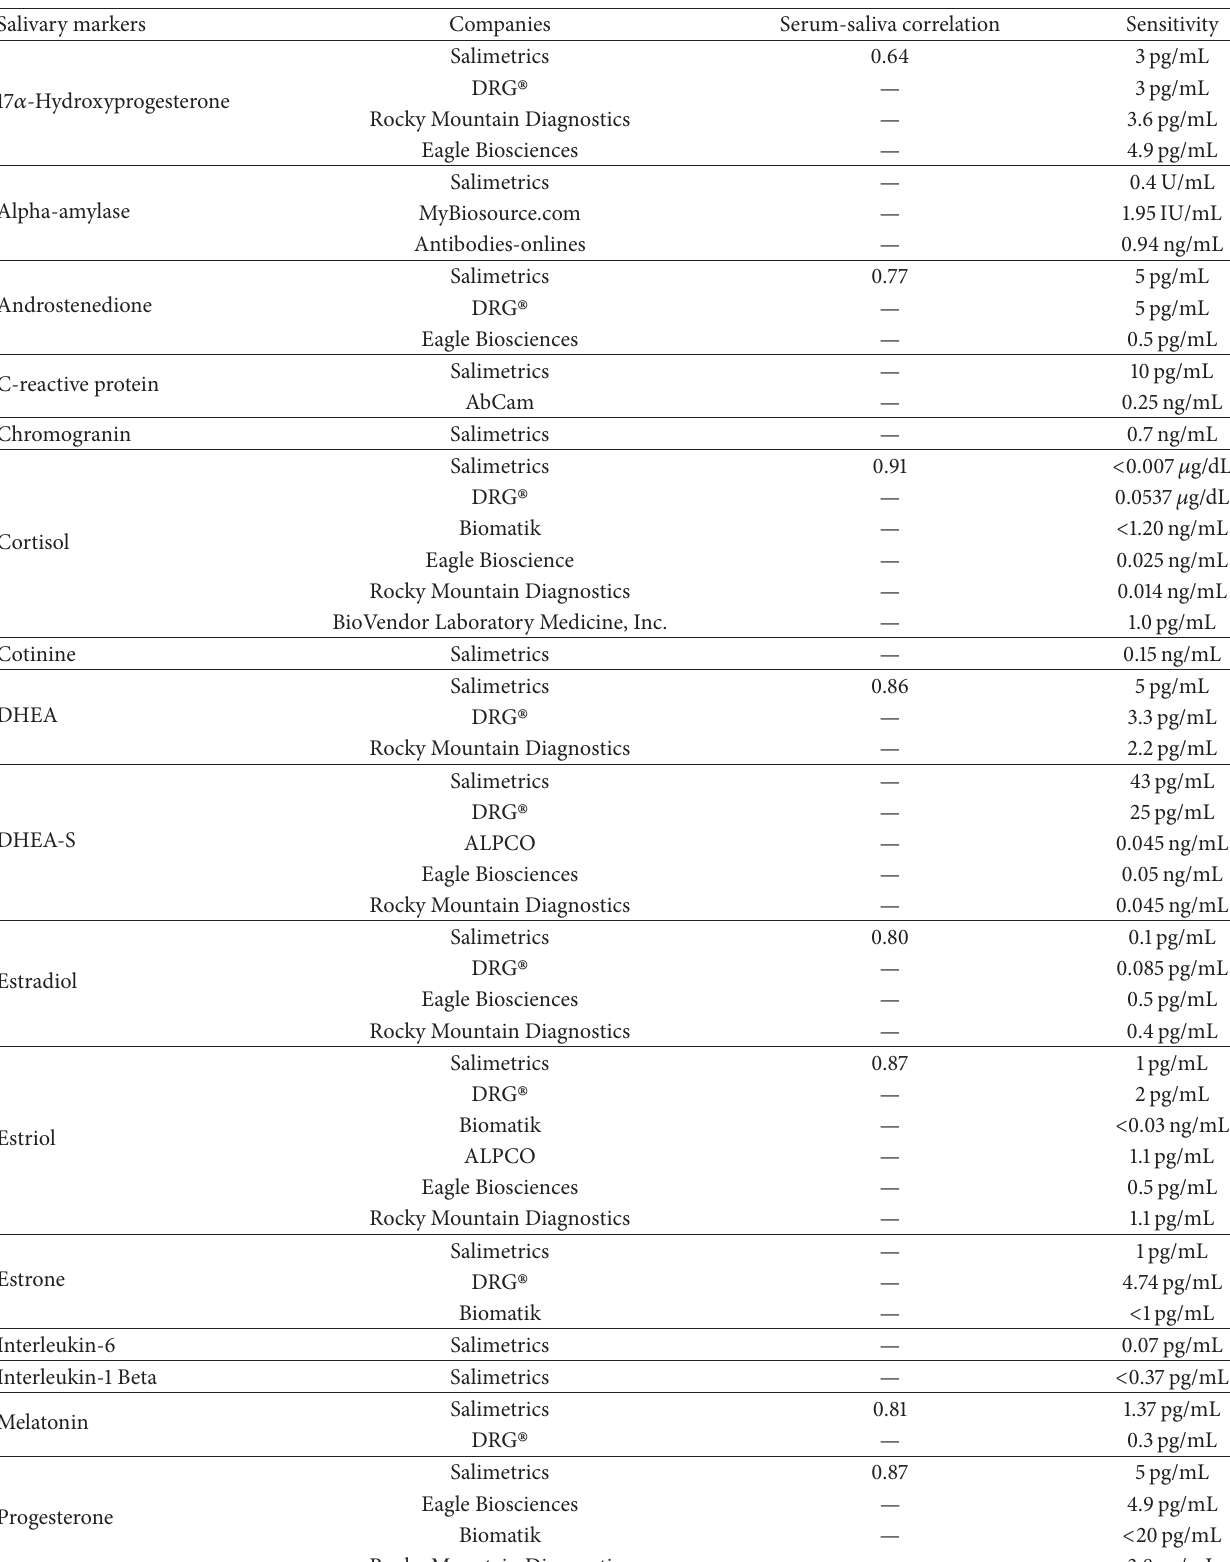
Table 2: Commercially available immunoassay (ELISA) for the detection of salivary